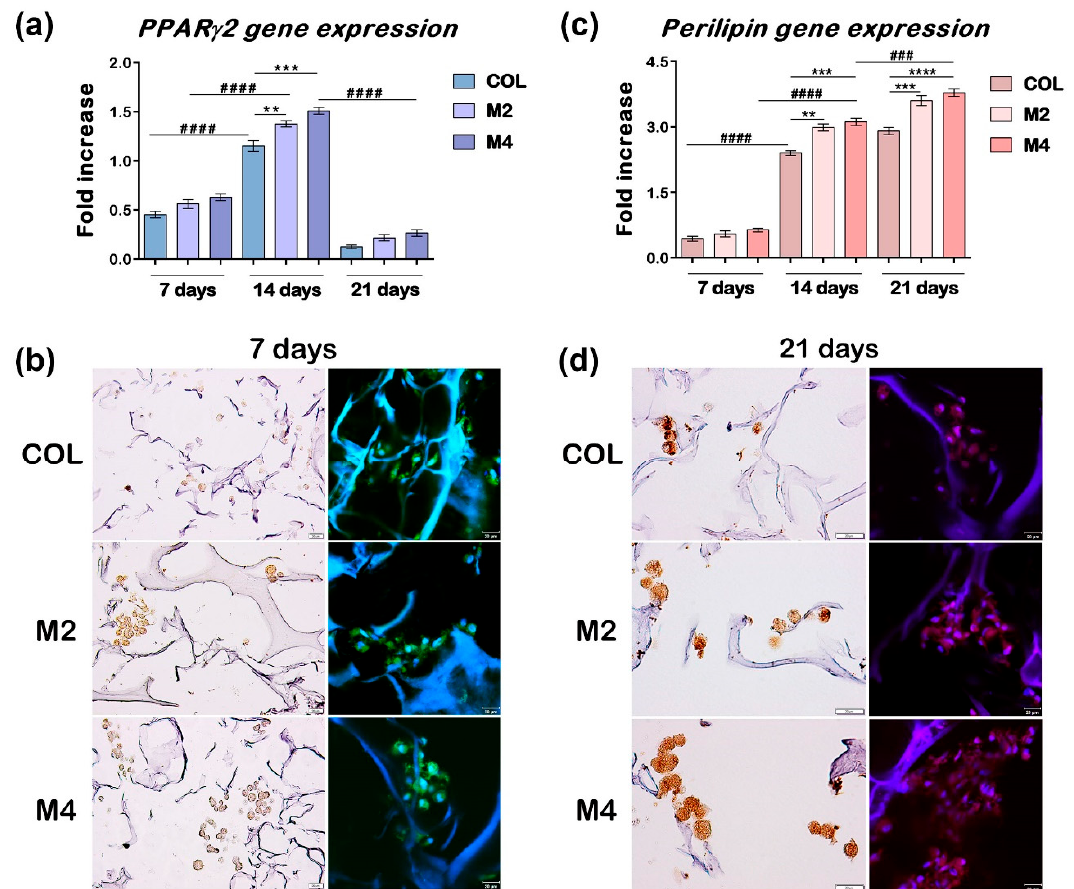
Figure 3. Evaluation of early and late markers of adipogenesis: ( a ) PPAR γ 2 gene expression level at 7, 14 and 21 days after induction of adipogenesis; ( b ) PPAR γ 2 protein expression visualized by immunohistochemistry and immunofluorescence coupled with confocal microscopy after 7 days of adipogenic differentiation; nuclei are stained in blue (DAPI) and PPAR γ 2 is stained in green (FITC); ( c ) Perilipin gene expression level at 7, 14 and 21 days of adipogenesis; ( d ) Immunohistochemistry and immunofluorescent staining of perilipin protein expression after 21 days of adipogenic differentiation. Nuclei are stained with DAPI (blue); perilipin is red (TRITC). All samples were evaluated in triplicate and the results are expressed as a mean ± S.D. Statistical significant differences are p<0.01 (**); p<0.001 (***); p<0.0001 (****). Highlighted with * are the statistical differences between different materials at the same time, and with # are the statistical differences between the same material but at different times.